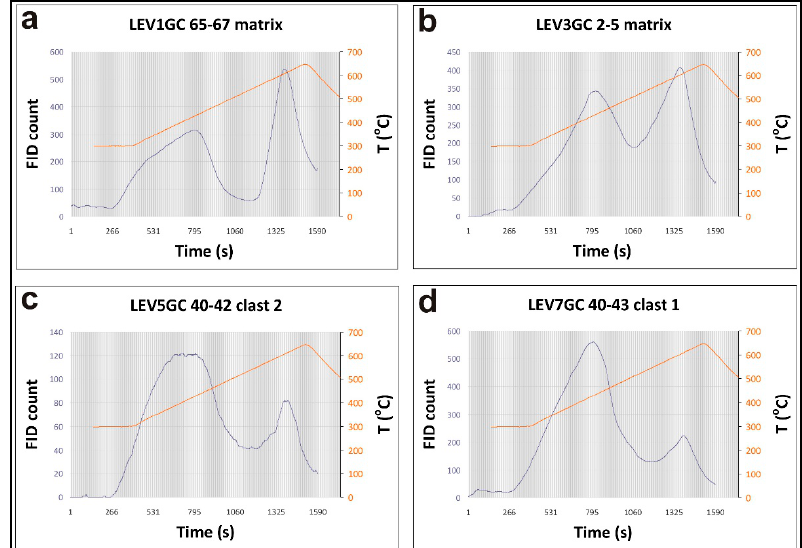
Figure 10. Distinct bimodal S2 peaks in the Rock-Eval pyrograms of samples from: ( a ) the Gelendzhik MV, ( b ) the Heraklion MV, ( c ) the Moscow MV, and ( d ) the Milano MV.